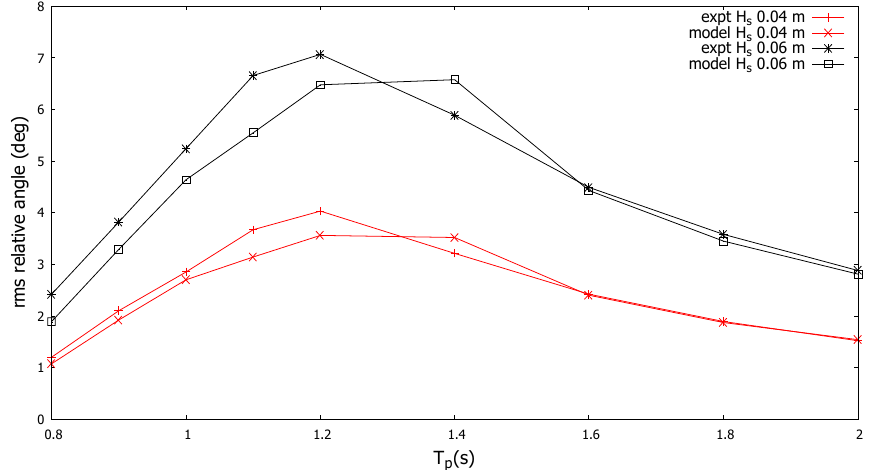
Table 1. Experimental values of 𝐻 (cid:3046) for JONSWAP spectra with 𝛾 = 3.3.